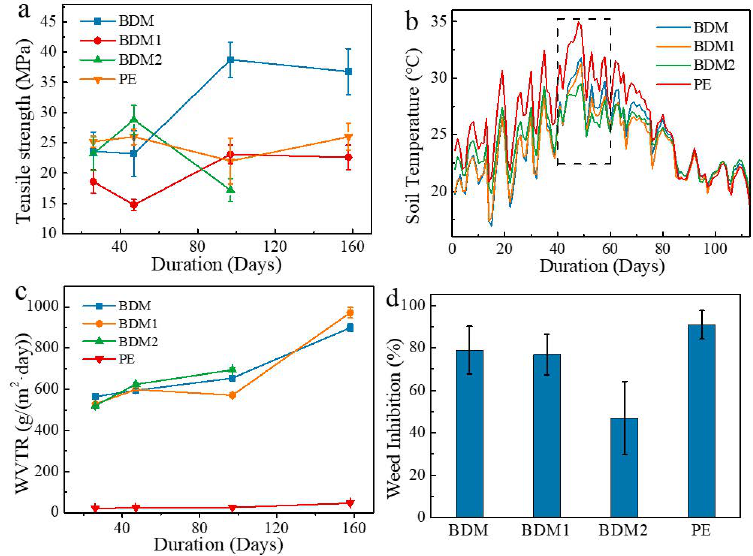
Figure 5. Tensile strength ( a ), soil temperature ( b ), WVTR ( c ) change with mulching duration and weed inhibition capability ( d ) of each